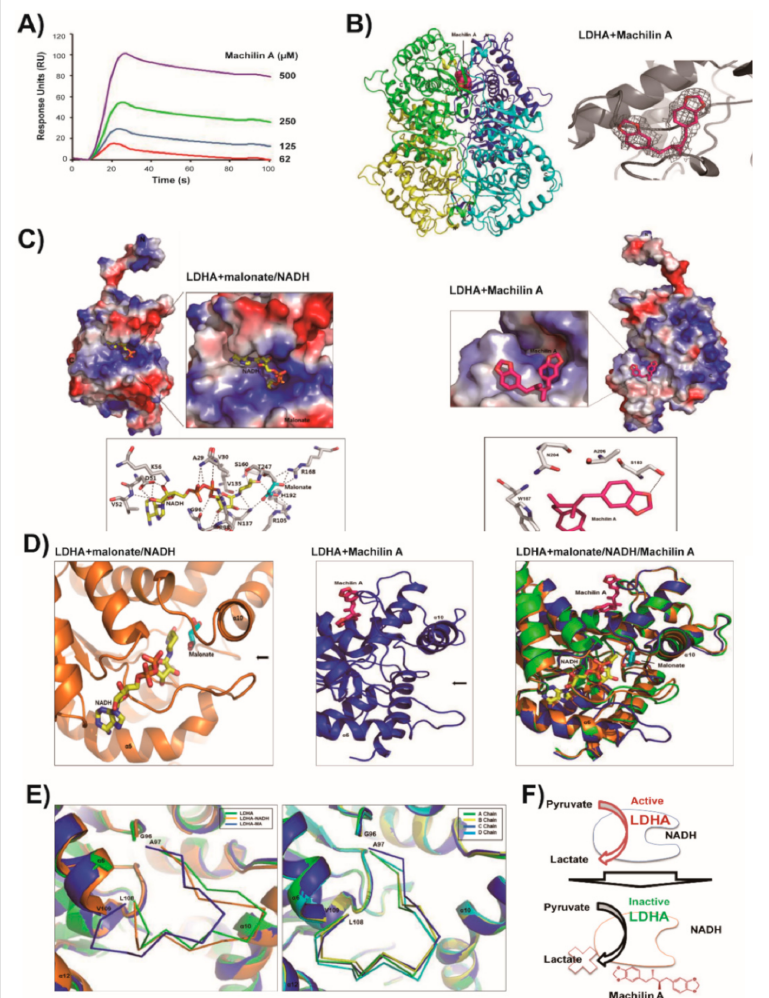
Figure 2. Surfaces and detailed interactions of Lactate dehydrogenase A (LDHA) and malonate / 1,4-dihydronicotinamide adenine dinucleotide (NADH) / Machilin A. ( A ) Surface plasmon resonance (SPR) biosensor analysis of LDHA binding to machilin A at 25 ◦ C. Machilin A sensorgrams for 62, 125, 250, and 500 µ M are shown. ( B ) Tetrameric structure of human LDHA. Chains A, B, C, and D of LDHA are shown in green, yellow, blue, and cyan, respectively. The 2 F o -F c electron density maps of LDHA with machilin A are contoured at 1 σ (gray) ( C ) Shown are the complexes and side chains of several amino acids of LDHA and malonate / NADH (left panel) and LDHA and machilin A (right panel). The relative distribution of the surface charge is shown with the acidic region in red, the basic region in blue, and the neutral region in white. Hydrogen bonds in LDHA complexes with malonate / NADH, and machilin A, respectively, are shown as black dotted lines. ( D ) The active-site loop regions of LDHA-malonate / NADH and machilin A are shown as closed and opened forms for substrate binding, respectively (left and middle panels). Superpositions of the LDHA complexes with malonate, NADH, and machilin A are shown (right panel). ( E ) Closed active-sites forms of LDHA complexes with malonate (green) and NADH (orange) are shown. Opened active-site form of LDHA complex with machilin A (blue) is shown. The active-site loops (97–108) from each chains of LDHA- machilin A tetramer are superimposed. ( F ) Scheme about inhibitory of LDHA activity by machilin